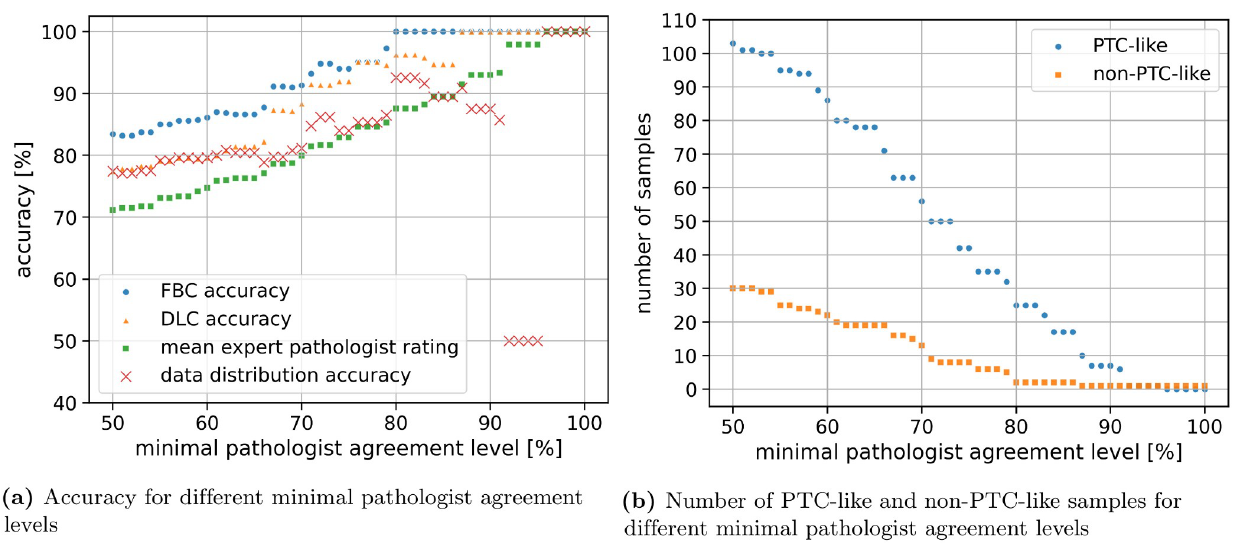
Fig 9. The evaluation on samples with a pathologist agreement level greater than a threshold is shown in (a). The feature-based classification (FBC accuracy, blue dots) outperforms the mean expert pathologist rating (green squares) and the accuracy achievable by knowing the data split (red crosses). The performance of the deep learning-based classification (DLC accuracy, orange triangles) varies between the FBC accuracy and the mean expert pathologist rating. The number of samples evaluated for different minimal pathologist agreement levels is shown in (b). The PTC-like samples are shown in blue dots and the non-PTC-like samples are shown in orange